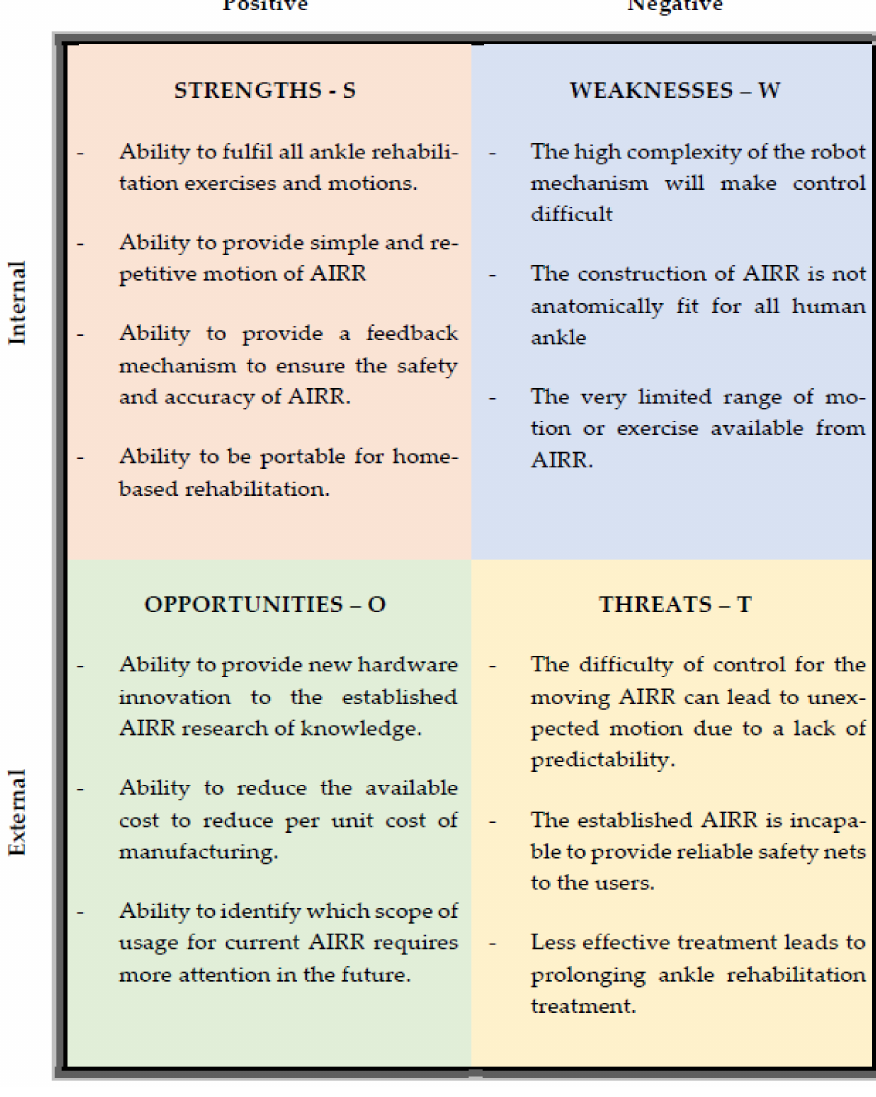
Figure 1. SWOT Analysis Diagram with examples of its components relating to